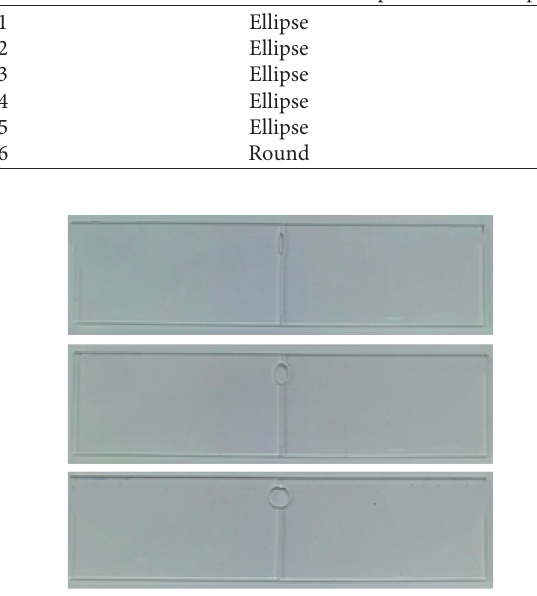
Figure 3: Specimen fracture